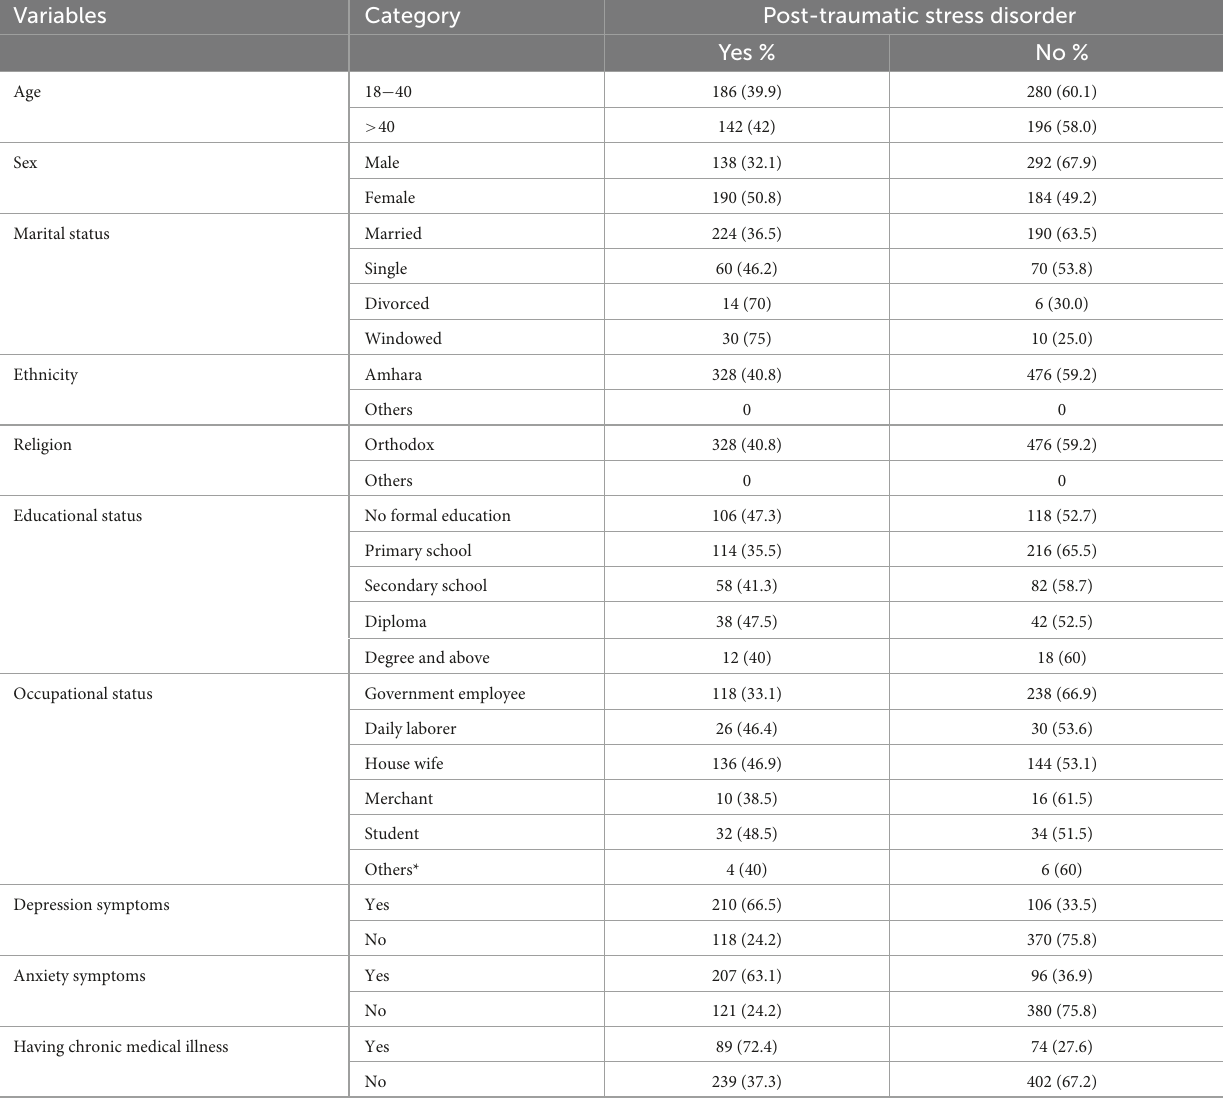
TABLE 2 Proportion post-traumatic stress disorder (PTSD) among the respondents at war affected area of Nefas Meewcha town, Northwest Ethiopia, 2022 ( n = 804).